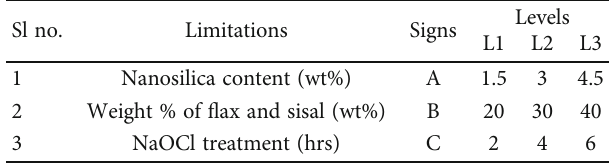
Table 1: Limitations and their stages of hybrid nanocomposite. Sl no.